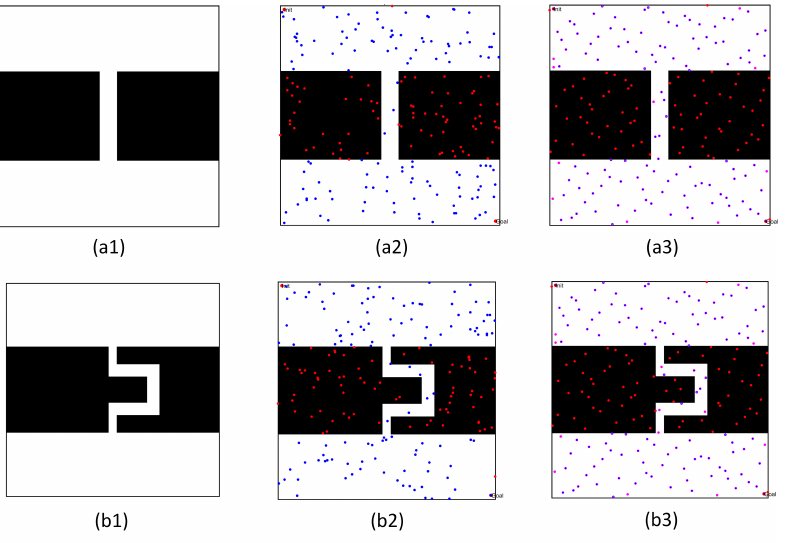
Figure 21. The workspaces and the sampling results of the single-channel environments: ( a1 , b1 ) Workspaces of different environments; ( a2 , b2 ) sampling points based on the random sampling method; and ( a3 , b3 ) sampling points based on the quasi-random sampling